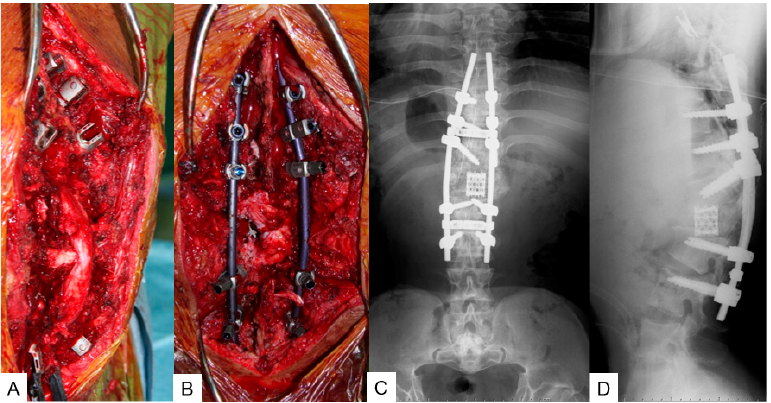
Figure 7. A 25-year-old man with achondroplasia; intra- and postoperative radiograms. ( A , B ) Intraoperative images; ( C , D ) postoperative radiograms.